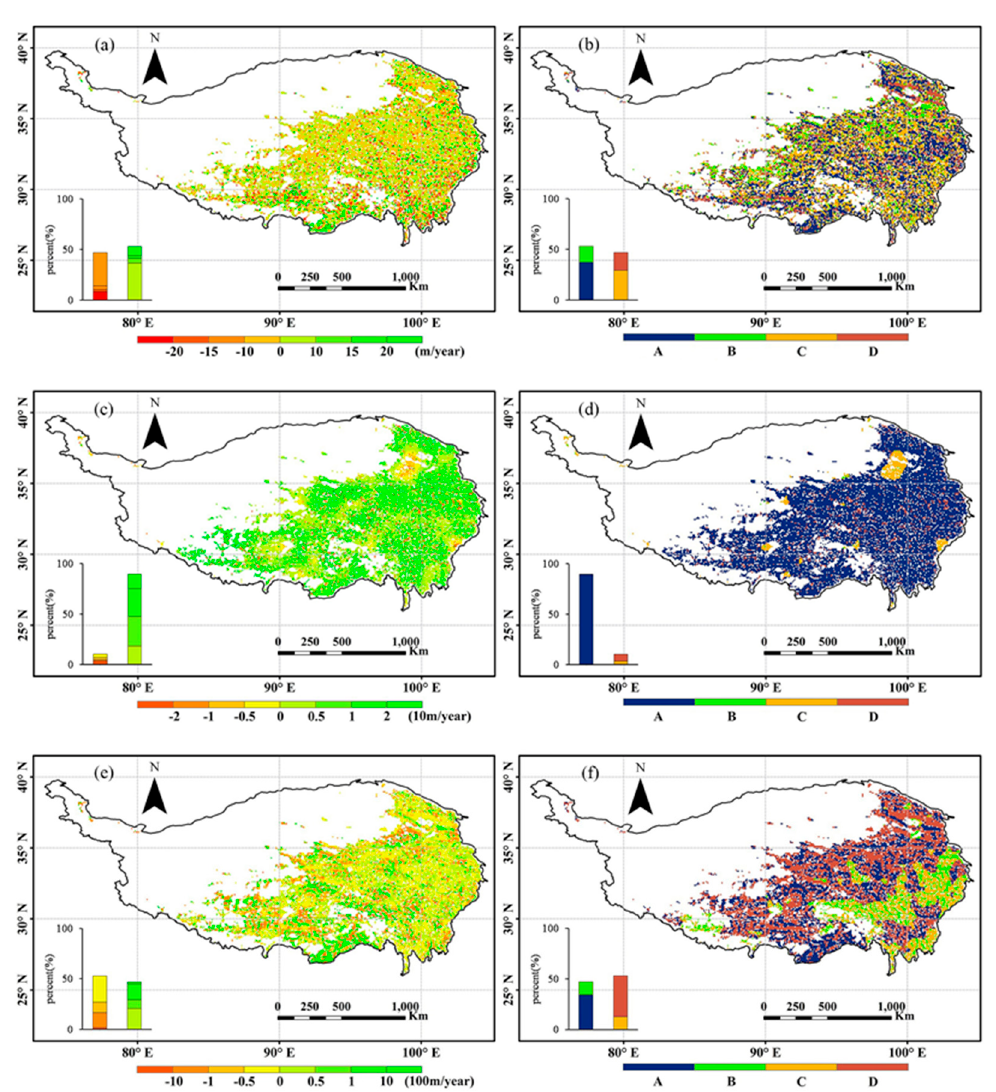
Figure 2. Spatial patterns of the elevational movement of ( a ) NDVI isolines (V_NDVI GS ), ( c ) temperature isolines (V_T GS ), and ( e ) precipitation isolines (V_P GS ), and of the direction of elevational movement of ( b ) NDVI isolines, ( d ) temperature isolines, and ( f ) precipitation isolines during the growing season. A, B, C, and D modes in ( b , d , f ) has the same indications as defined in Figure 1. The proportion of pixels in each interval is shown at the lower left of each graph.